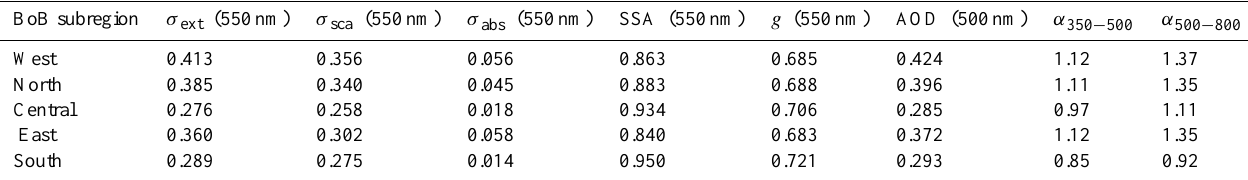
Table 2. Aerosol optical parameters in the 5 BoB sub-regions through OPAC model.